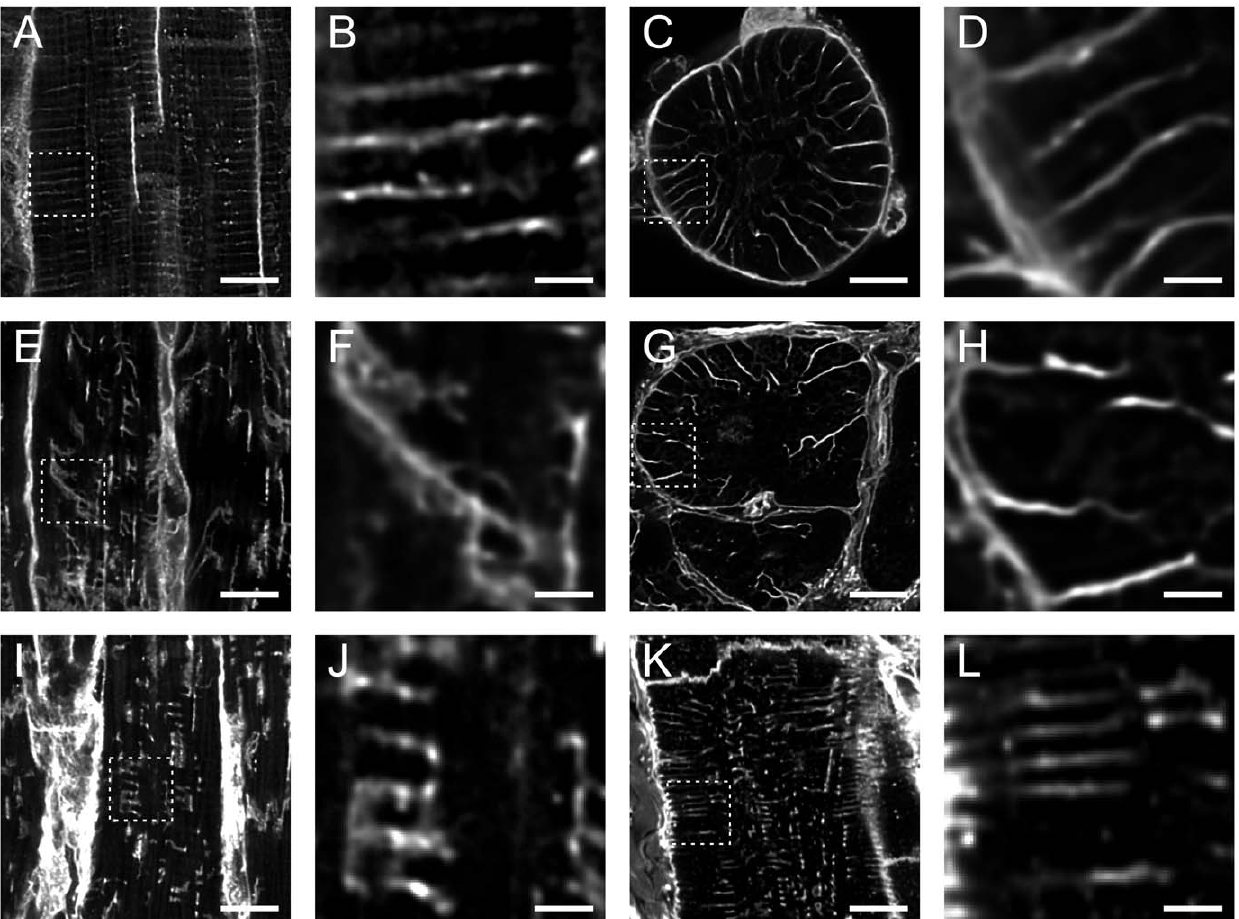
Figure 2. WGA labelling of t-tubules in normal and failing human ventricular myocytes. The top row shows images from normal cells in longitudinal and transverse sections (left to right) and corresponding images from diseased tissue is shown in the lower two rows. ( A ) Longitudinal sections of normal tissue shows uniformly spaced t-tubules. Occasional axial elements can also be seen. ( B ) A magnified view of the region shown by the box in A . ( C ) Normal myocyte in transverse section. A radial ‘‘spoke-like’’ organization of t-tubules is apparent. ( D ) Enlarged view of the region shown by the box in C . ( E , I , K ) Longitudinal sections from three different diseased cells, demonstrating the range of t-tubular morphologies found in disease with corresponding ( F , J , L ) magnified views. Note that while the enlarged view in L appears relatively normal, other regions with the same cell ( K ) are clearly abnormal. ( G ) Transverse section showing that, while the general direction of diseased tubules is radial, tubules are more disorganized. ( H ) Magnified view of the region shown by the box in G . Images are projections of 5 slices with z depth of 1 m m. Scale bars in overview images are 10 m m and in close up images 2 m m.